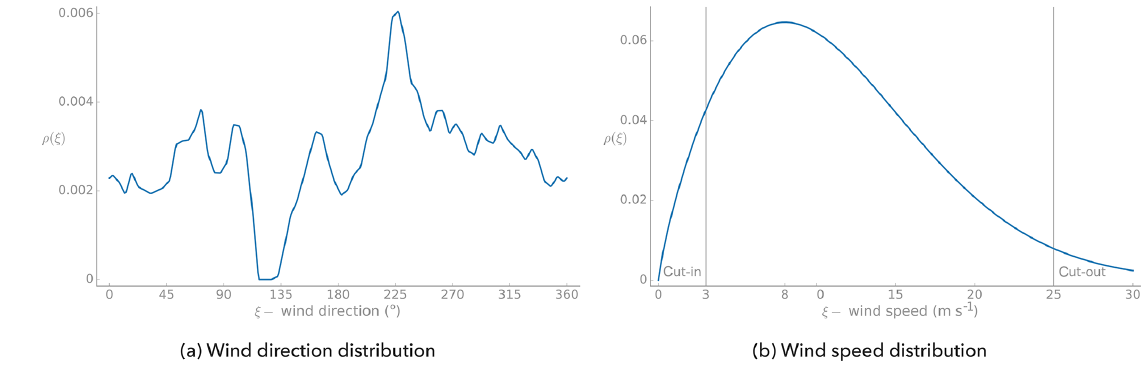
Figure 3. The uncertain variable probability distributions. The vertical lines show the cut-in and cut-out speed of a single wind turbine.